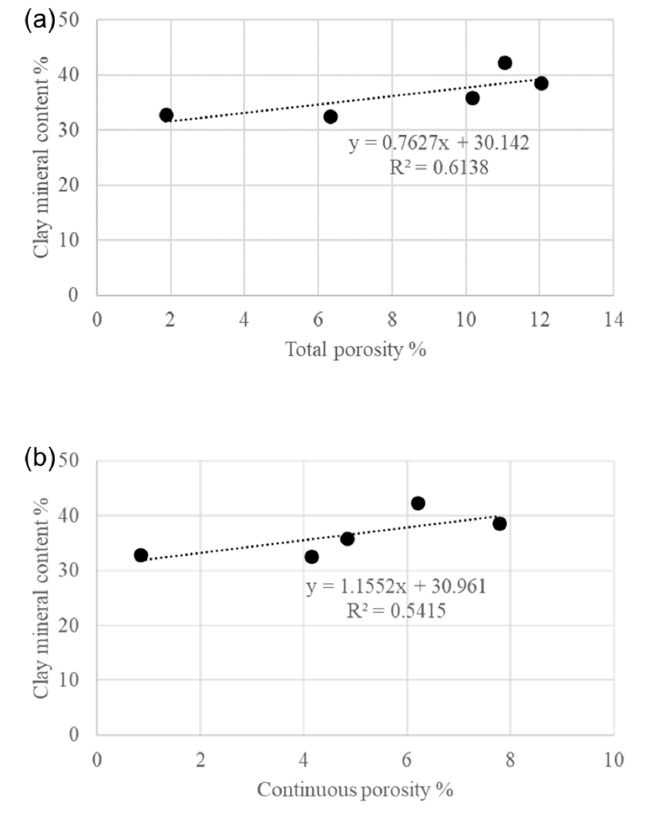
Figure 7. ( a ) Crossplot of total porosity versus clay content for the studied samples. ( b ) Continuous porosity versus clay content of the studied samples.